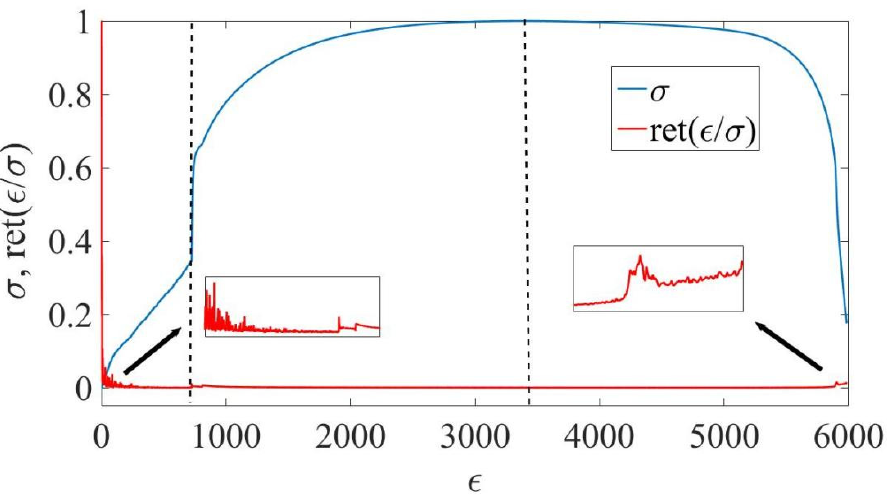
Figure 1. The dynamics of the initial stress–strain curve across time and its standardized returns. Dotted lines separate the stress–strain curve into three stages. Arrows point out the stage of the transition from elastic to plastic deformation and the stage of fracture in the time series of returns.